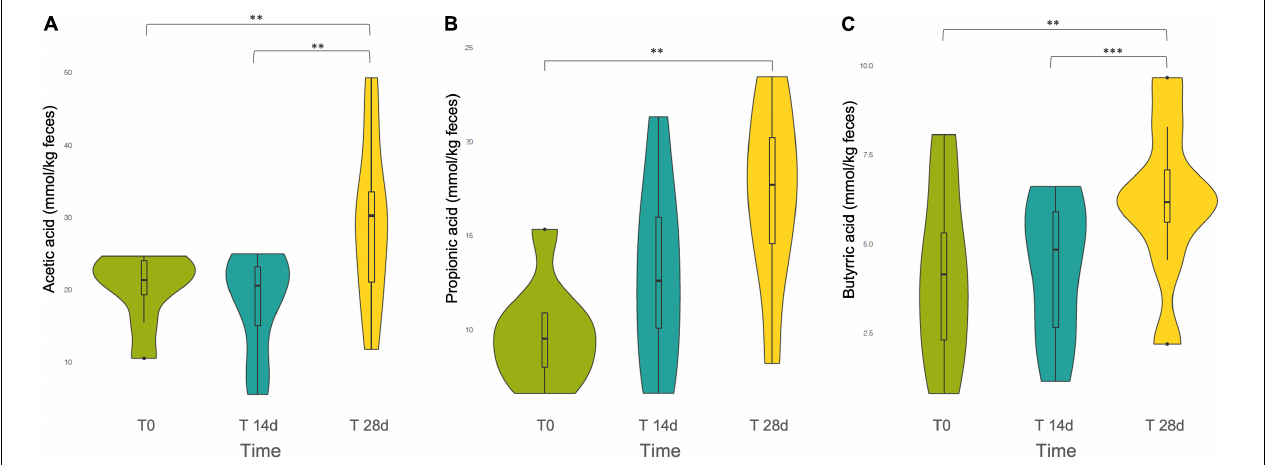
FIGURE 4 | Violin plot of the short chain fatty acids (SCFAs) (A) Acetic acid, (B) Propionic acid, and (C) Butyric acid released during the tannin intervention, at different time points: T0, T14d, and T28d. ** and *** indicates statistically significant differences by ANOVA and Bonferroni post-hoc test: ∗∗ p < 0.01, ∗∗∗ p <